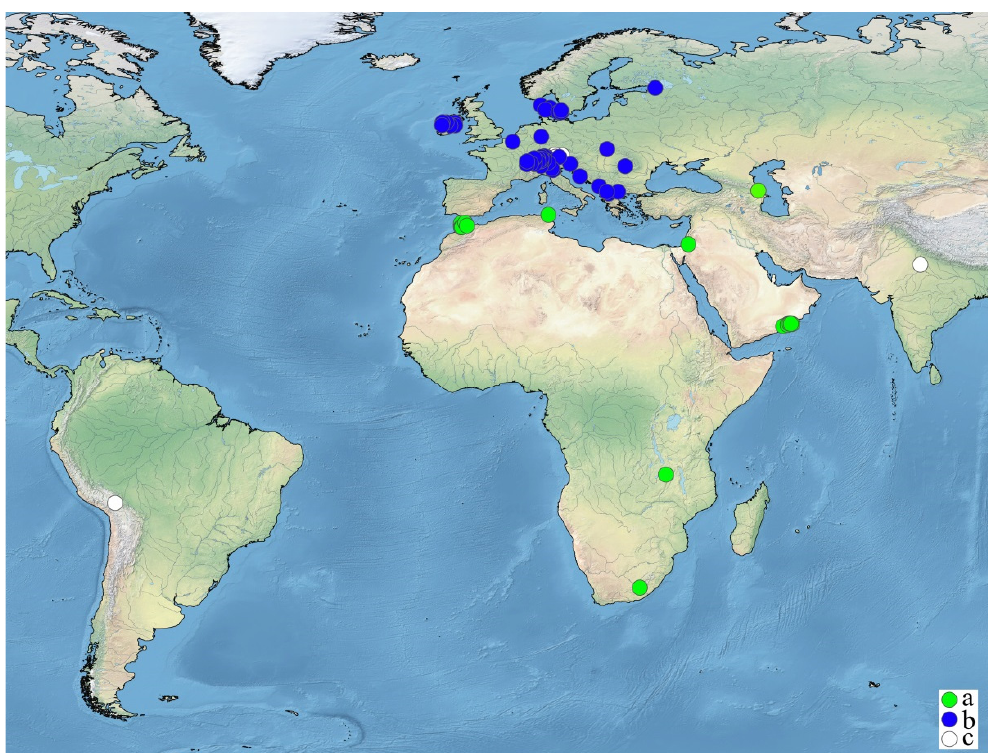
Figure 8. Distribution area of the records tentatively referring to Chara denudata in Africa and Asia ([2,17,23,40–42,52,67,68,71,72], LE, B, W, studied specimens), distribution area of C. dissoluta in Eu- rope ([24], this study), and published records associated with these species [24,74–76]: a— C. denu- data ; b— C. dissoluta ; c—published records associated with these species, restudy of their vouchers is required.